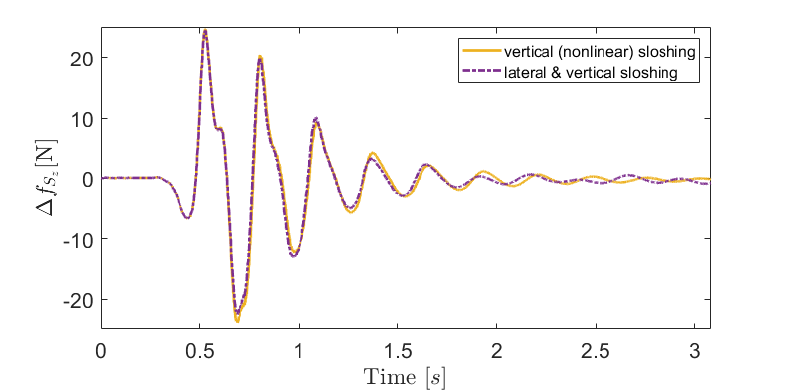
Figure 7. U ∞ = 18m/s and w g structural mode.